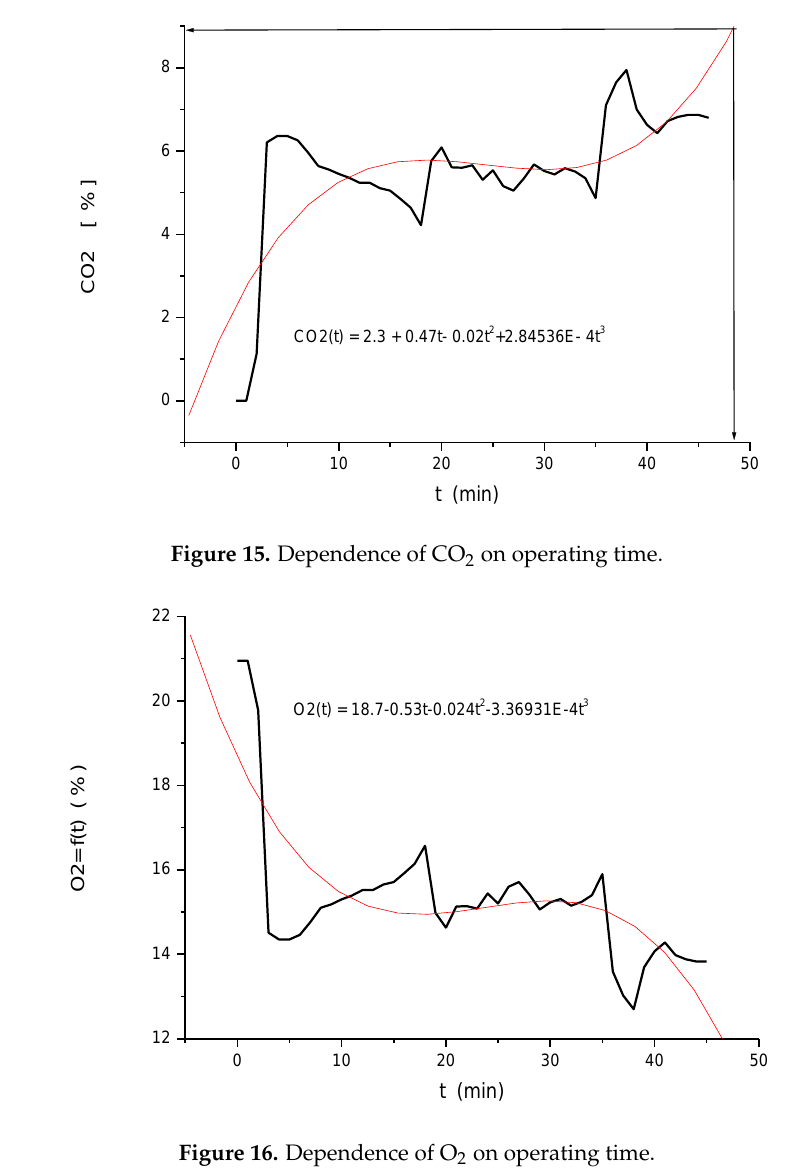
Figure 16. Dependence of O 2 on operating time.